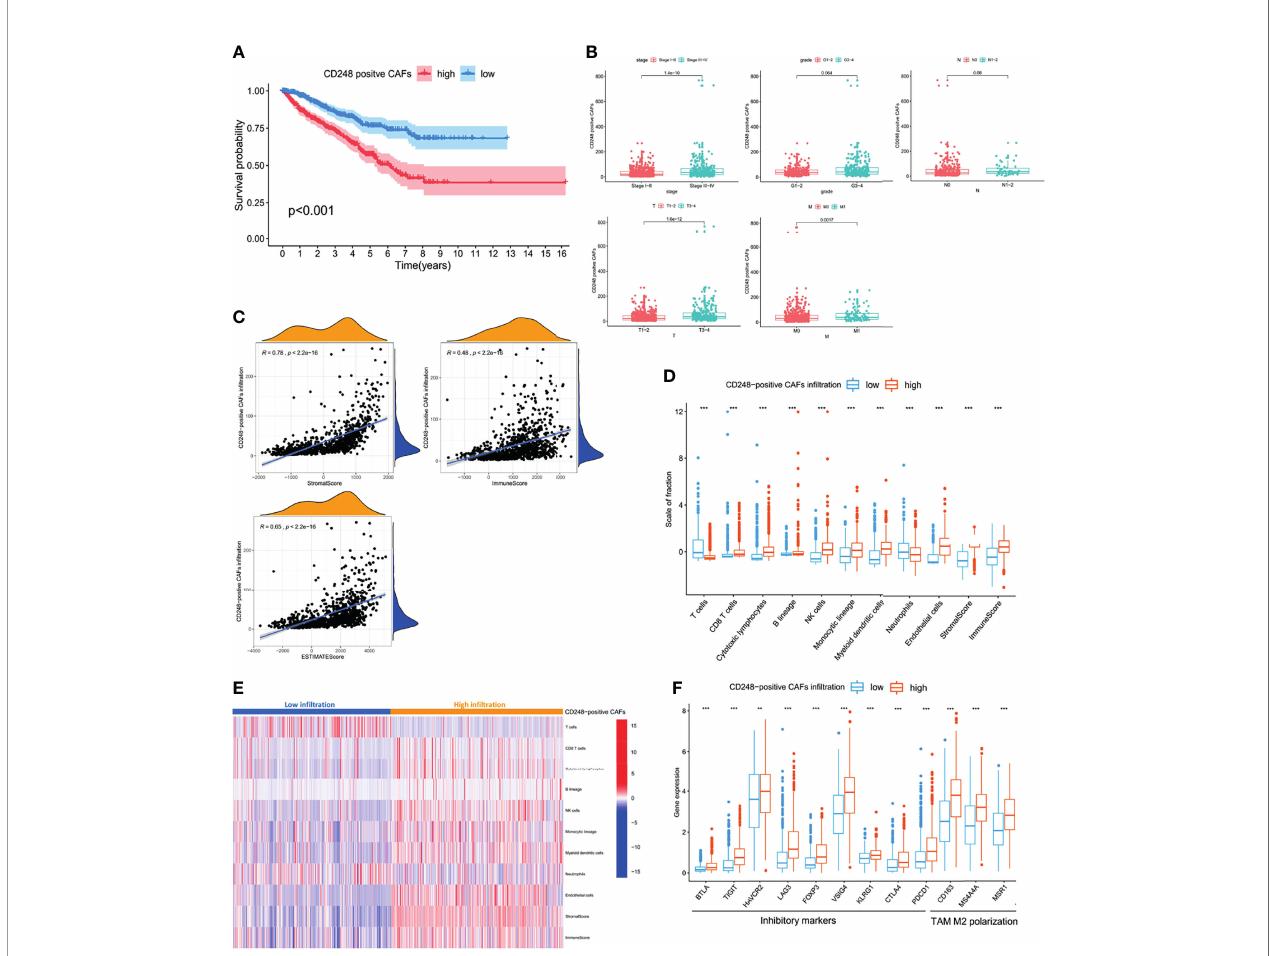
FIGURE 5 | CD248 + CAF in fi ltration was suggestive of a poor prognosis in RCC patients and immunosuppression. (A) Kaplan – Meier analysis of the OS associated with high and low CD248 + CAF in fi ltration. (B) Clinicopathological correlation of CD248 + CAF in fi ltration in RCC. (C) Correlation analysis between the CAF in fi ltration score and TME scores. (D) Box plot of the comparison of cells in the TME based on high and low CD248 + CAF in fi ltration groups. (E) Heatmap of TME cells shown after grouping by CD248 + CAFs. (F) Box plot of the comparison of inhibitory immune molecules based on high and low CD248 + CAF in fi ltration groups. p < 0.05 was considered statistically signi fi cant. ** p < 0.01; *** p <